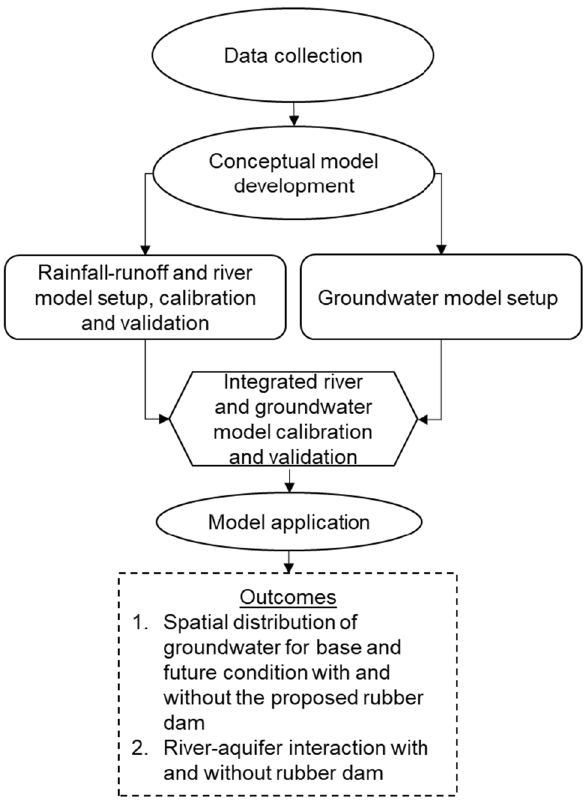
Fig. 4 Catchment delineation for rainfall–runoff model setup. The flow generated from catchment-1 (10,986 km 2 ) is used as an upstream flow boundary condition for the modeled Mohananda river. The run- off generated from catchment-2 (830 km 2 ) is distributed along the segment of the Mohananda river in the river